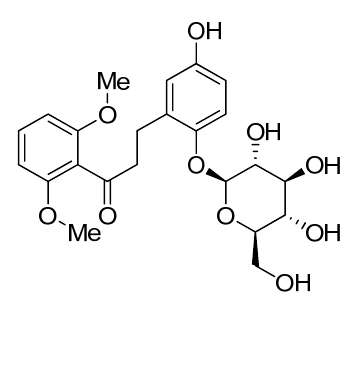
Figure 1. Structure of